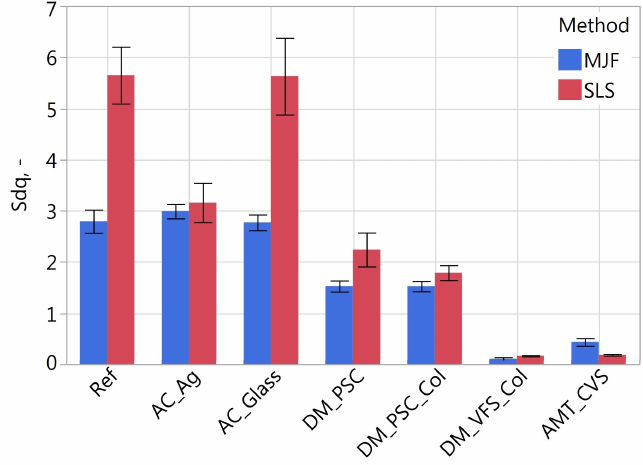
Figure 13. Root mean square gradient Sdq of measured samples.